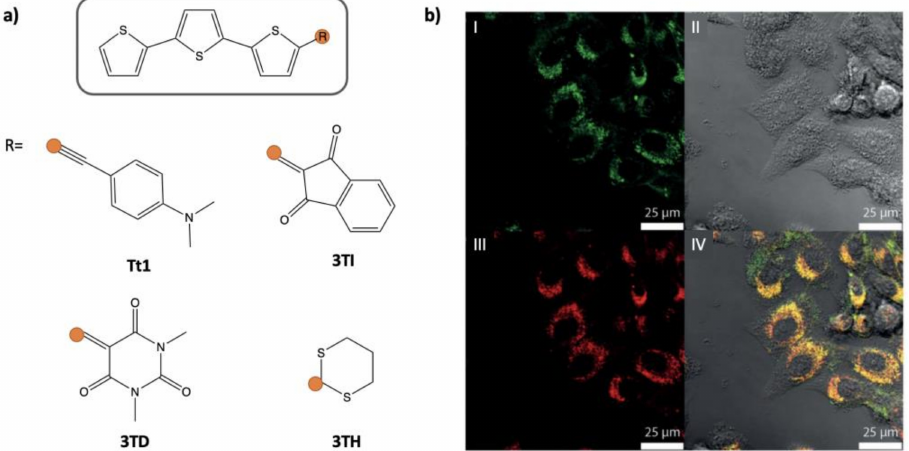
Figure 2. ( a ) Different terthiophene-based compounds used as fluorescent dyes. ( b ) In vitro staining of HeLA cells with ( I ) Tt1; ( II ) brightfield image; ( III ) LysoTracker1 Red (specific dye for lysosome); and ( IV ) their overlapping images. Adapted with permission from ref. [519]. Copyright 2013 RSC